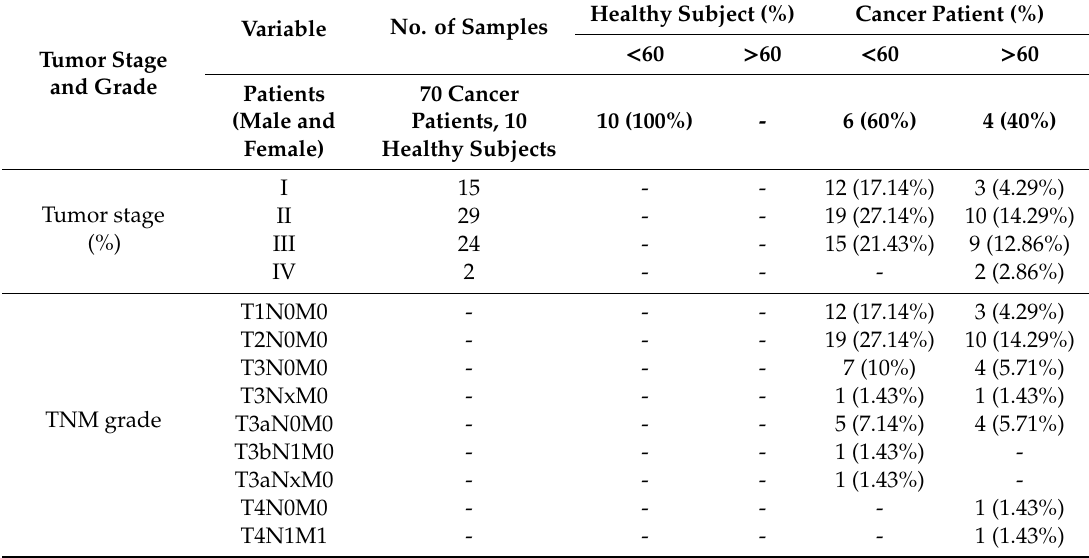
Table 1. Clinicopathological features of experimental samples (human kidney carcinoma tissues and normal kidney